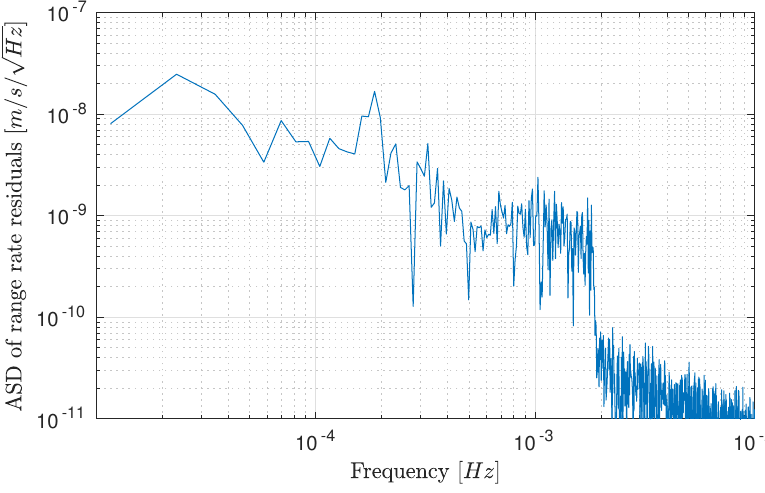
Figure 8. Amplitude spectral density of range rate residuals for Day 1 after the last (28th)